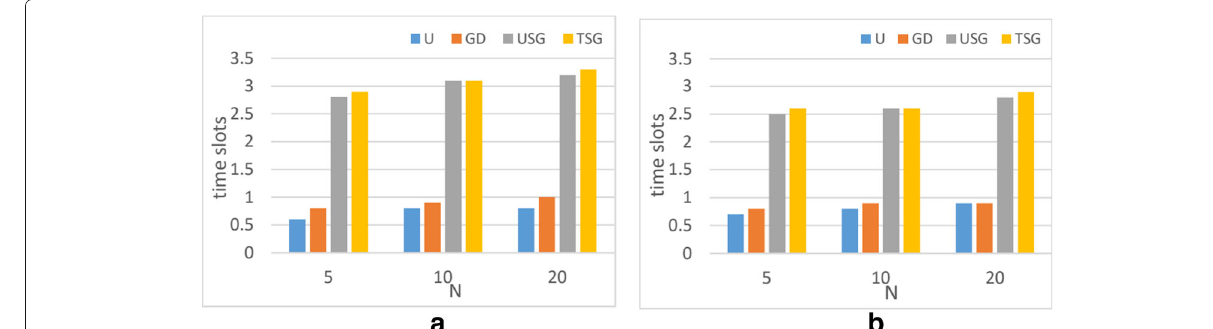
Fig. 8 Time efficiency comparison. a Foursquare. b